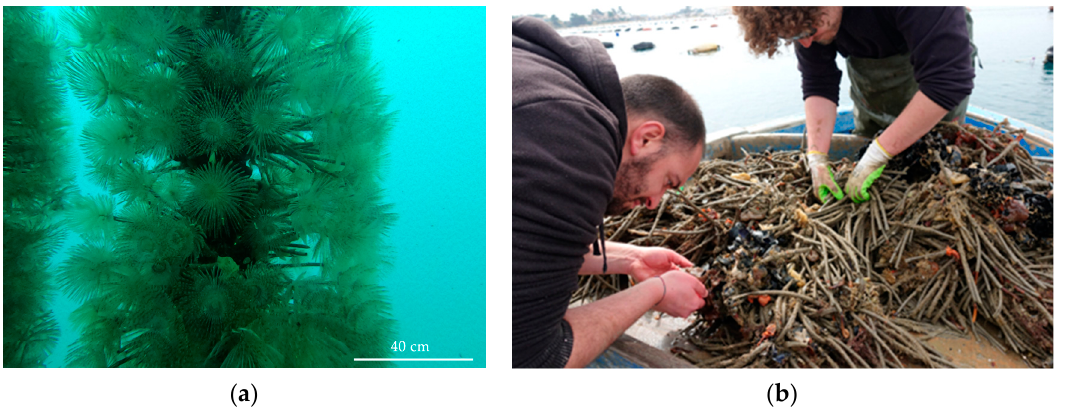
Figure 1. ( a ) Underwater picture showing several specimens of S. spallanzanii on the collectors; ( b ) phase of collecting worms.